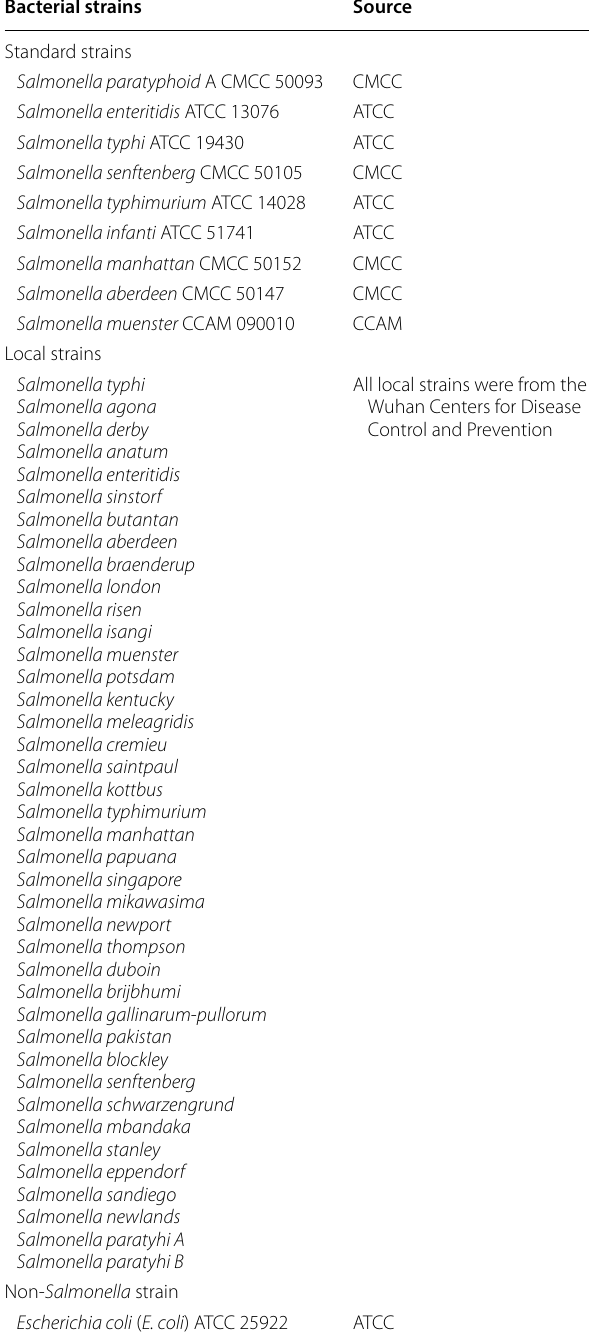
Table 1 Bacterial strains used in this study Bacterial strains